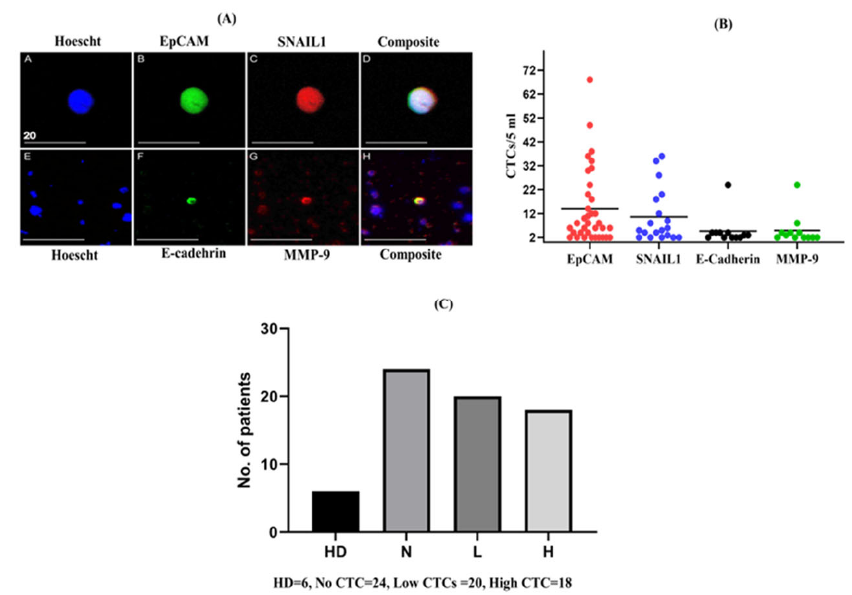
Figure 1. Enumeration of circulating tumour cells (CTCs) and numbers of different subpopulation of CTCs in patients with colorectal carcinoma (CRC). The figure depicts: ( A ) representative images of CTCs detected from patients with CRC captured using an Olympus Fluoview FV1000 Confocal Microscope (scale bar: 20 µ m); ( B ) a comparison of the number of different subpopulations of CTCs detected in patients with CRC; and ( C ) the number of populations recruited in different groups based on the range of CTC counts, along with healthy donors. (HD, healthy donor; N, No CTC; L, low CTC-positive group; H, high CTC-positive